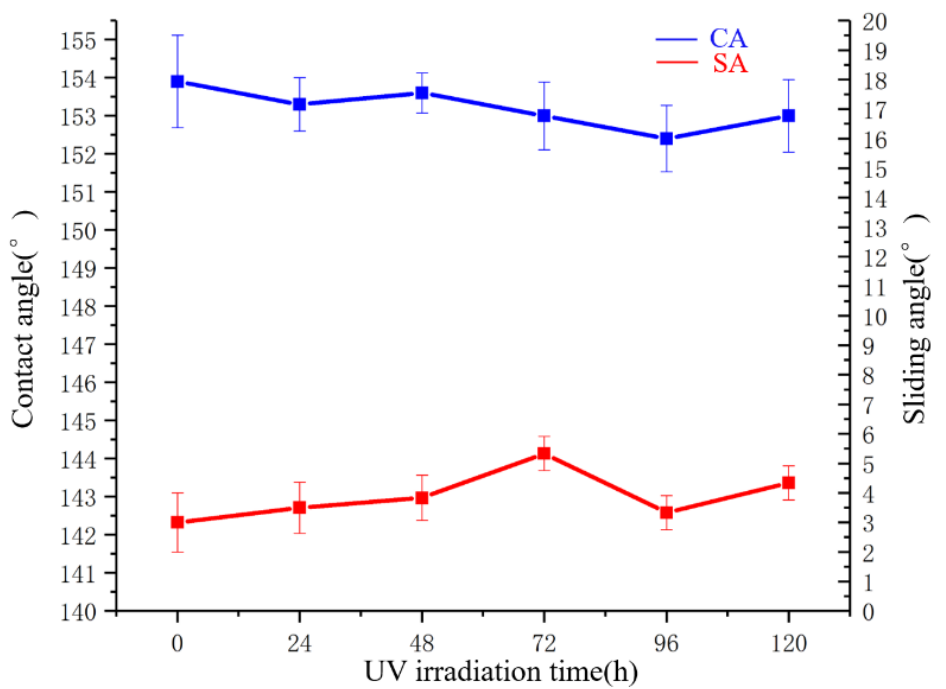
Figure 21. CA and SA under different UV irradiation times.